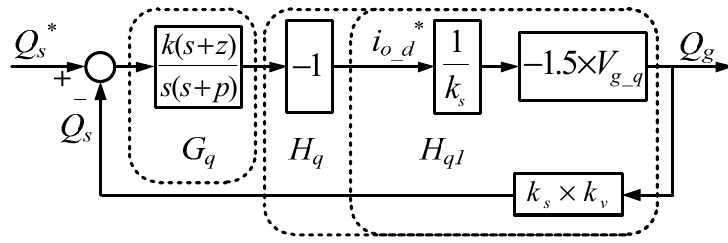
Figure 10. Outer reactive power control loop (* indicates commands).